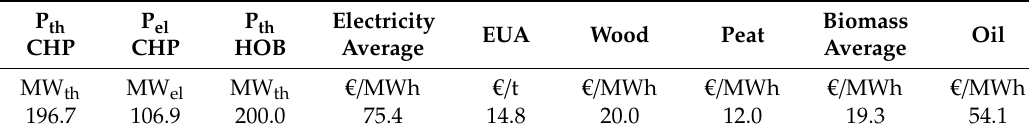
Table 2. Economic values for simulated power plants.